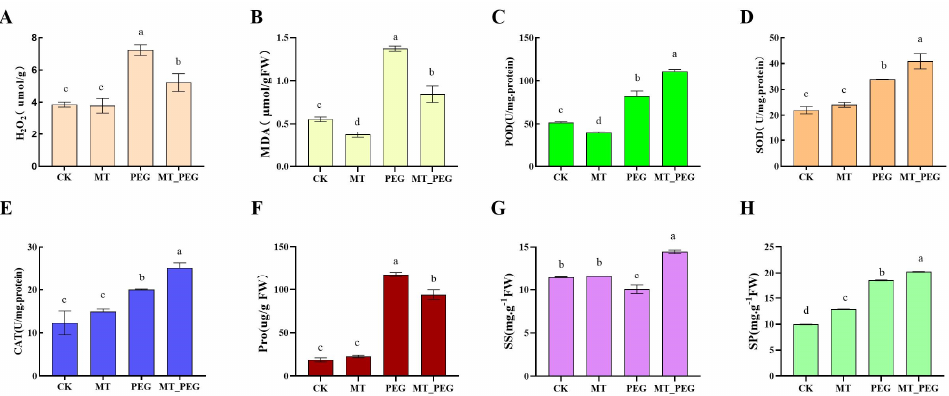
Figure 2. Physiological responses of chrysanthemum seedlings under drought stress. Contents of H 2 O 2 ( A ) and MDA ( B ). Activities of POD ( C ), SOD ( D ), and CAT ( E ). Contents of proline ( F ), soluble sugar (SS) ( G ), and soluble protein (SP) ( H ). CK, control; MT, exogenous melatonin treatment; PEG, drought stress; MT_PEG, drought stress with exogenous melatonin treatment. The data are presented as the means ± SEs (n = 3). Different letters indicate significant differences at p < 0.05.